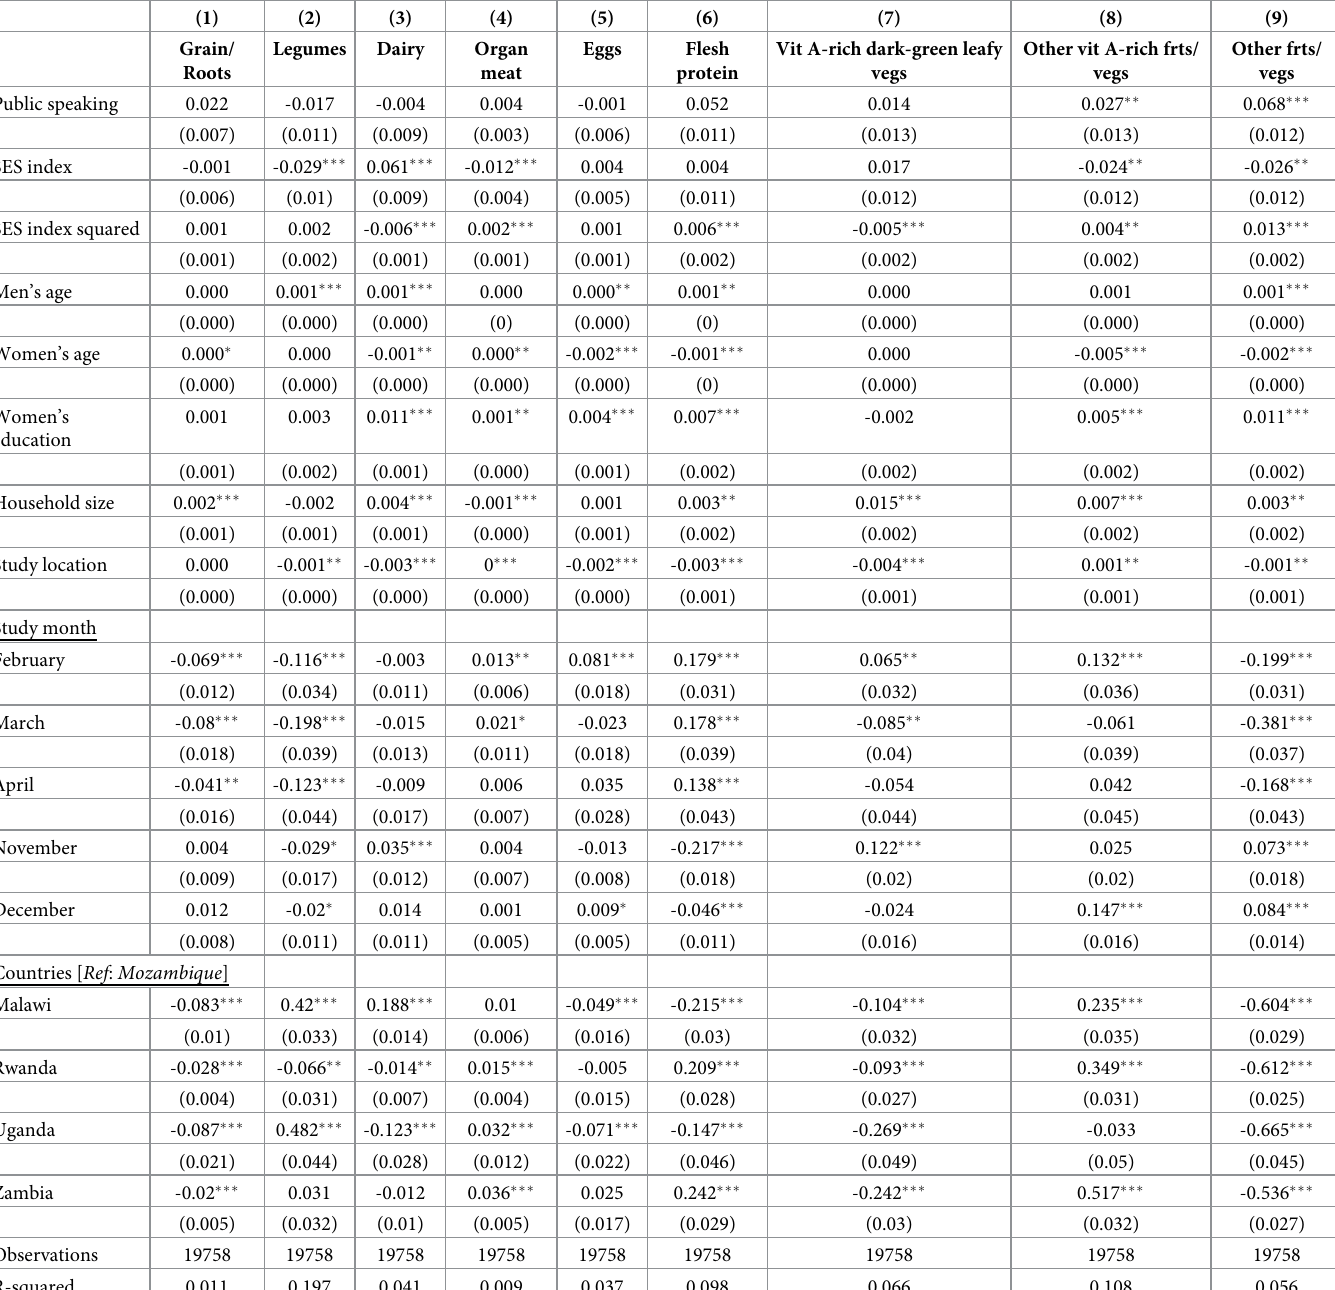
Table 19. Marginal effects of Logistic regression for food groups consumed–leadership domain (Comfortable speaking in public in � 1